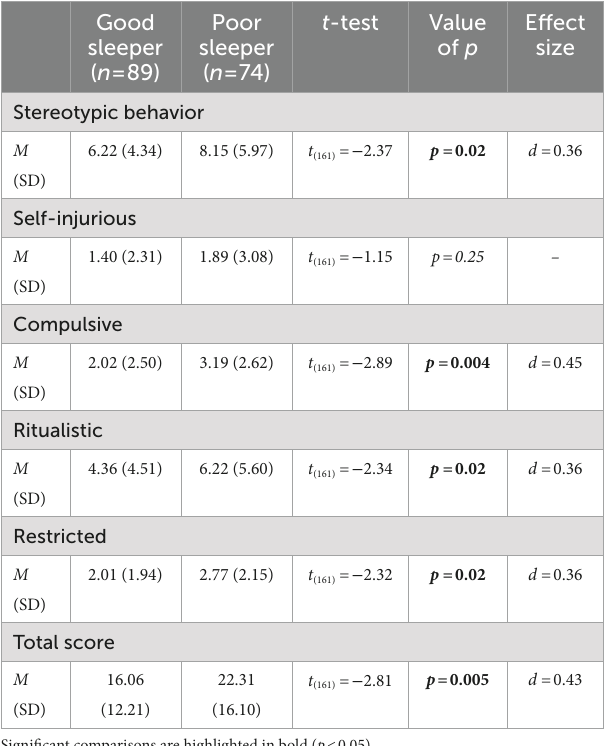
TABLE 6 Differences in RBS-R scales between poor and good sleepers.